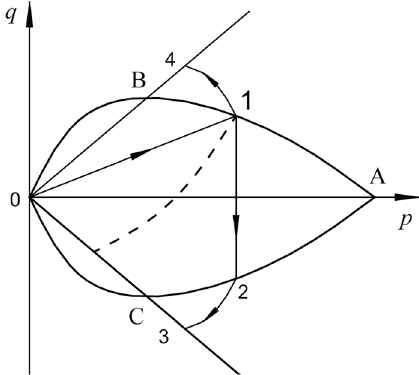
Fig. 2. Yield locus of Original Cam-Clay model and Original Sekiguchi-Ohta